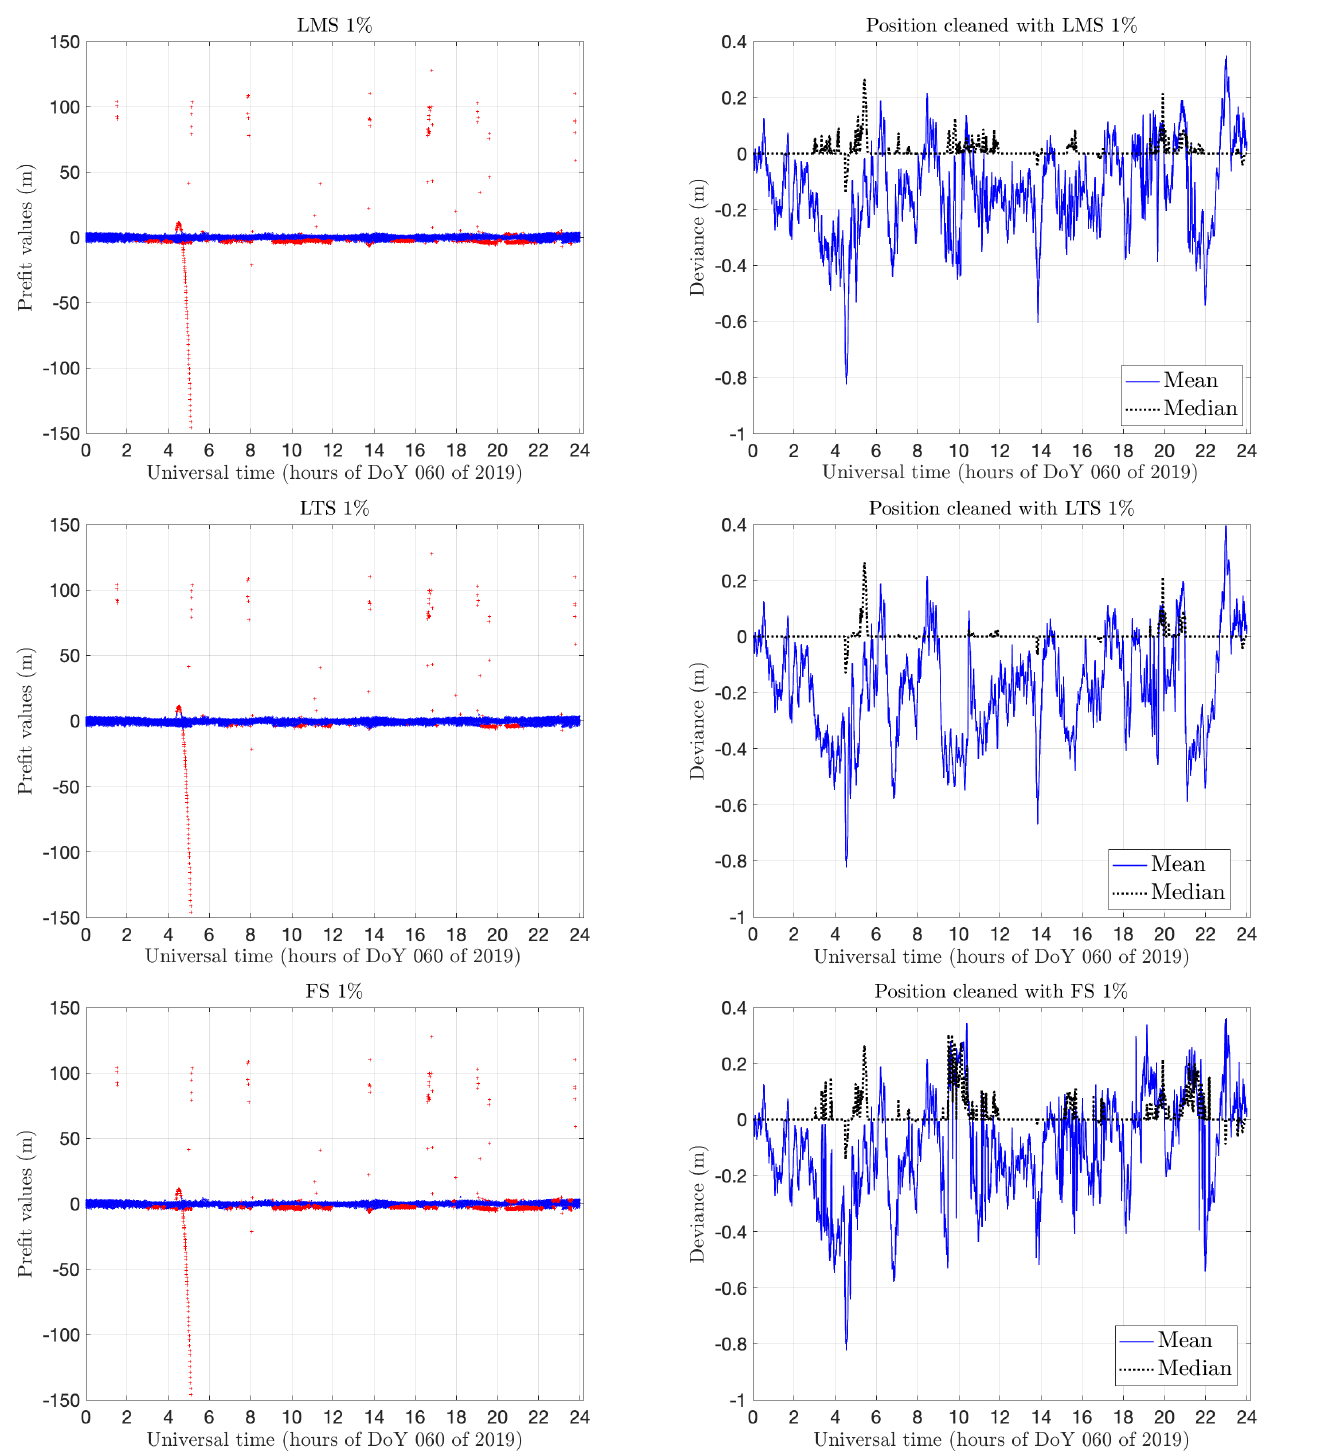
Figure 4. Outlier detection against LMS regression ( top ), LTS ( middle ) and FS ( bottom ) with a sliding time window of 10 epochs. The left column depicts the pre-fit residuals (blue) with outliers as marked in red, whereas the right column depicts the evolution of mean (blue) and median (black) in each case. FS shows ‘more centered’ means and medians with respect to LMS and